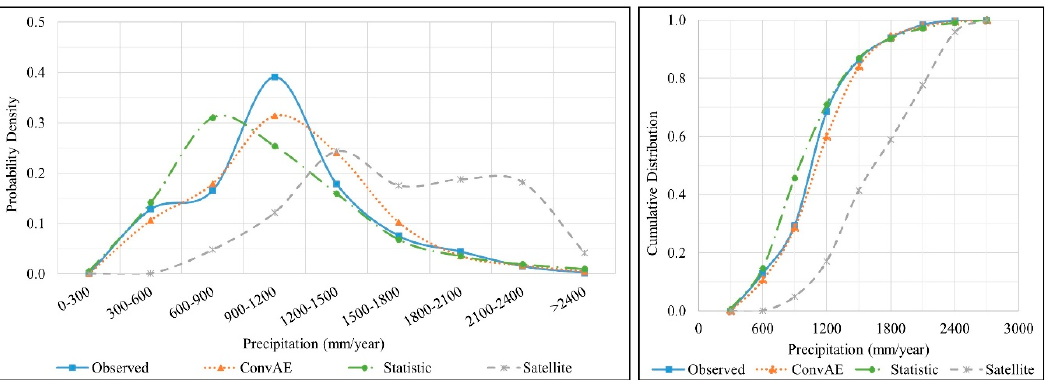
Figure 9. Probability distribution of the total precipitation by grid cells in 2014.